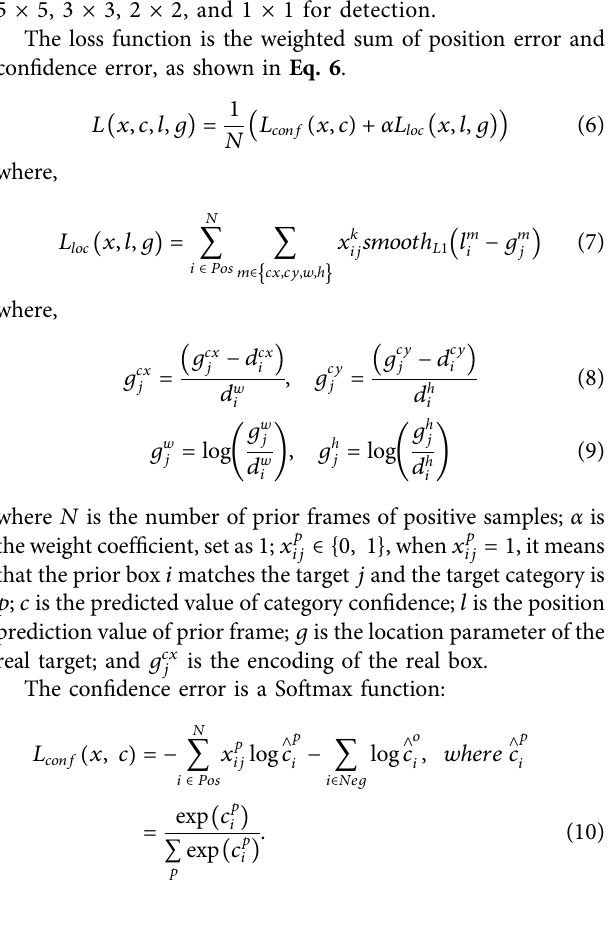
5 × 5, 3 × 3, 2 × 2, and 1 × 1 for detection.